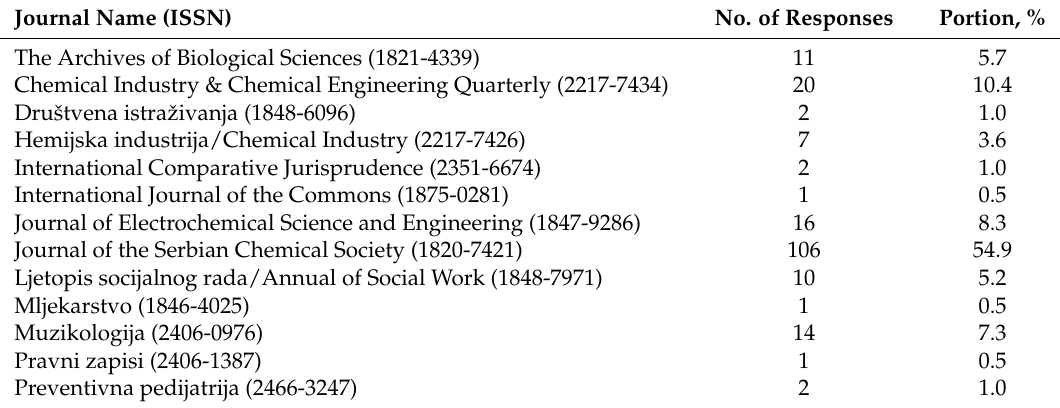
Table 1. Journals involved in the survey and the number of responses